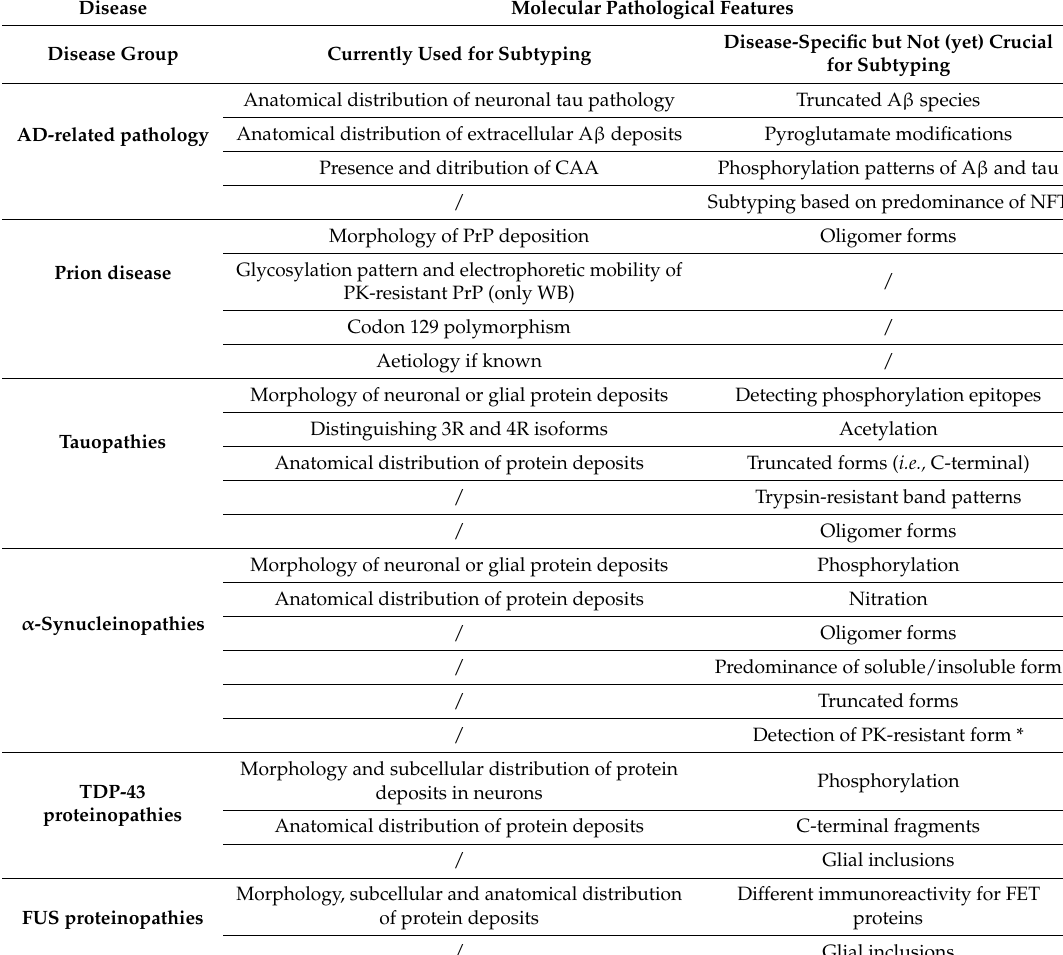
Table 3. Molecular pathological features that are currently considered for subtyping and those, which are disease-specific but not yet implemented for classifications. * Depends also on the method ( i.e.